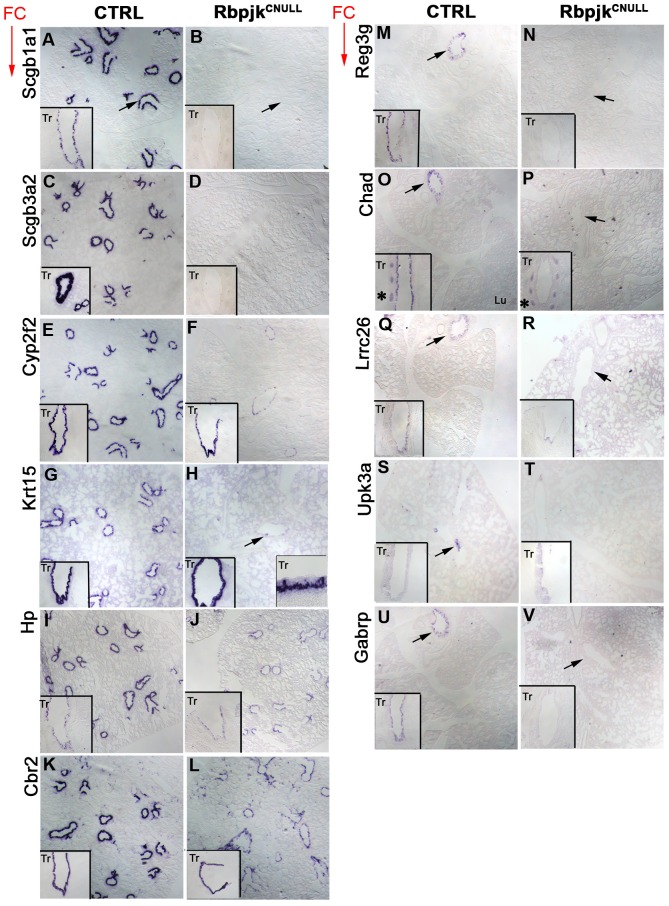
Expression patterns of the genes identified by transcriptional profiling.RNA in situ hybridization (ISH) analysis of the expression of candidate genes in in control and RbpjkCNULL lungs at E18.5. All genes were expressed in the airways in widespread (A–K) and localized (M–U) patterns and downregulated in the RbpjkCNULL lungs (B–L, N–V). Chad expression was detected in precursors of the cartilage (O, asterisk) and this expression was unaffected in RbpjkCNULL (P, asterisk). Arrows in the panels indicate comparable regions of the airways. Red arrows indicate that the panels have been vertically ordered with respect to Fold Change (FC) in gene expression reported by microarray profiling. ISH on CTRL and RbpjkCNULL sections was performed simultaneously and the staining was developed for the same period for time. Tr = Trachea, Lu = Lung.